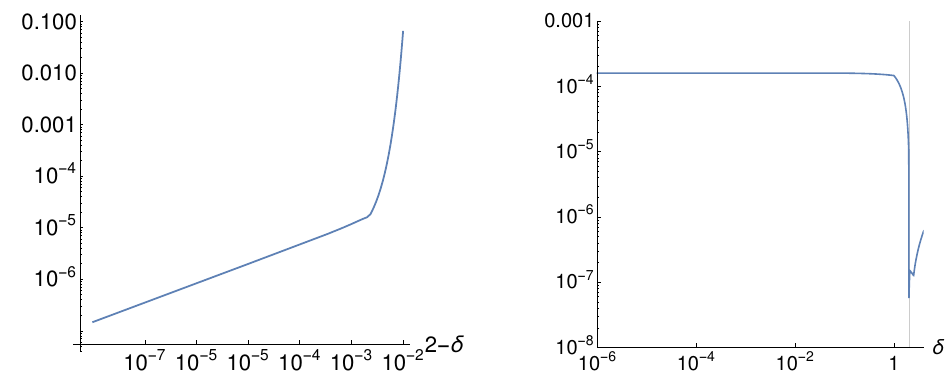
Figure 8 . Projected exclusion bounds for g (cid:30)e in the magnetic set-up (left) and laser set-up (right).